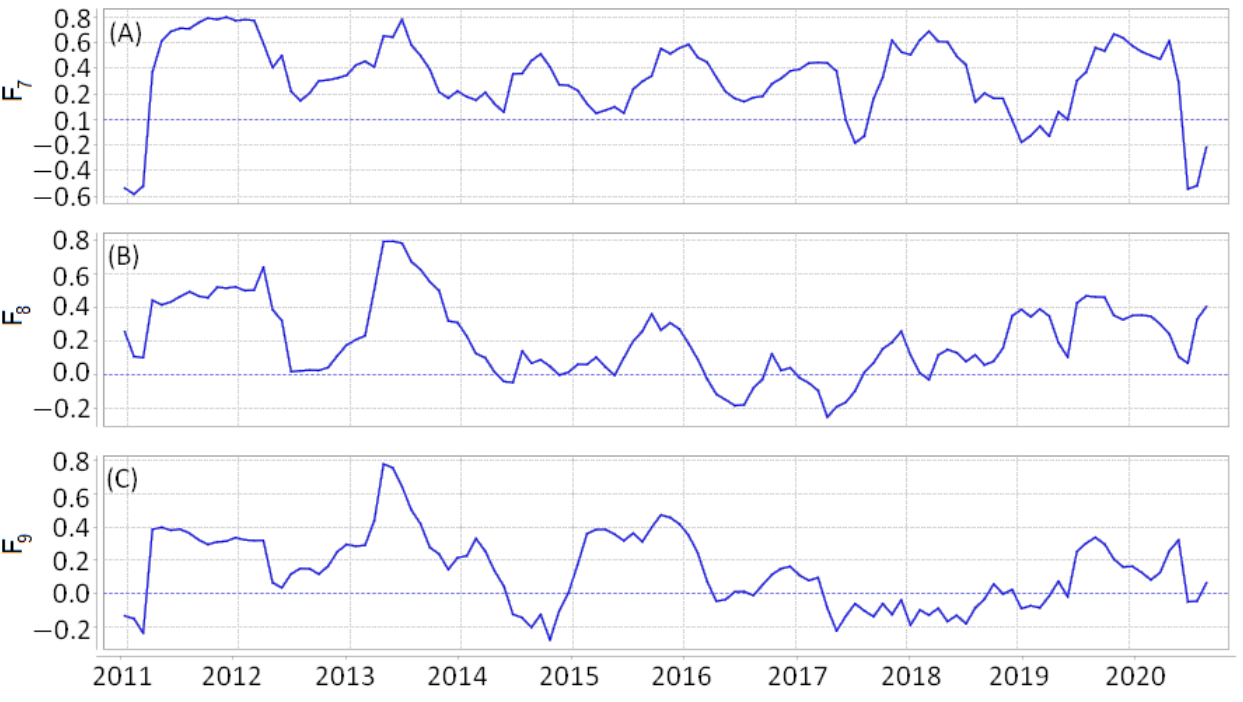
Figure 12. Japan. Time series at point 35.45 ◦ N and 139.2 ◦ E. ( A ) Field F 7 ; ( B ) field F 8 ; ( C ) field F 9 . Correlation fields F 7 , F 8 , and F 9 carry information about the spatial relationship be- tween the values of the change in the rate of different pairs of deformation types. The mini- mum or maximum fields of the correlation fields combine this